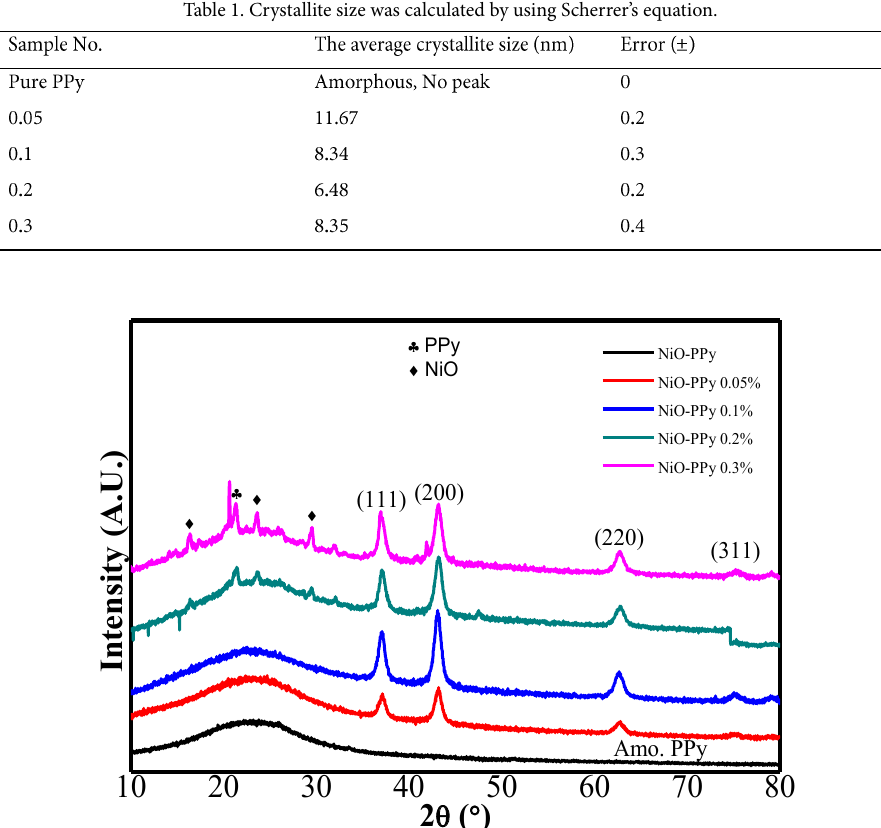
Fig. 1. XRD spectra of pure PPy and NiO-PPy nanocomposites